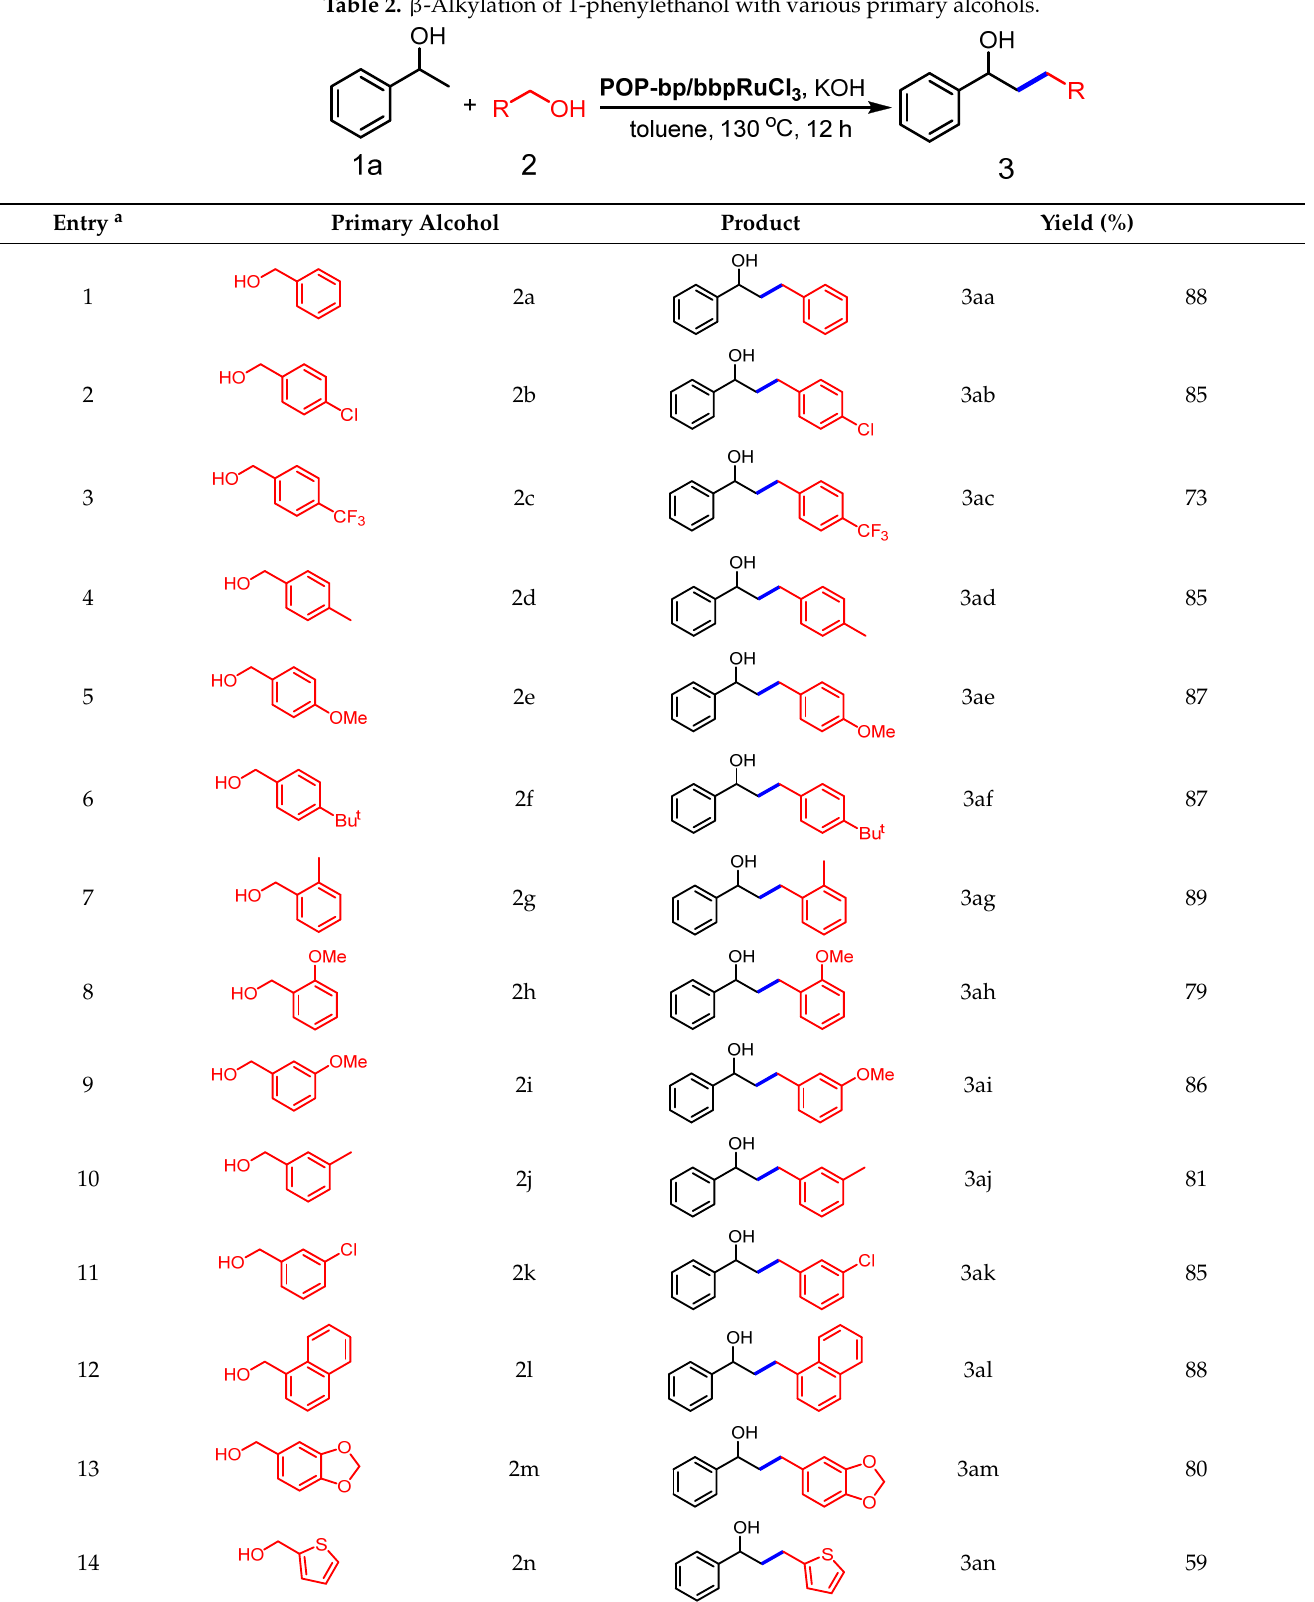
Table 2. β -Alkylation of 1-phenylethanol with various primary alcohols.